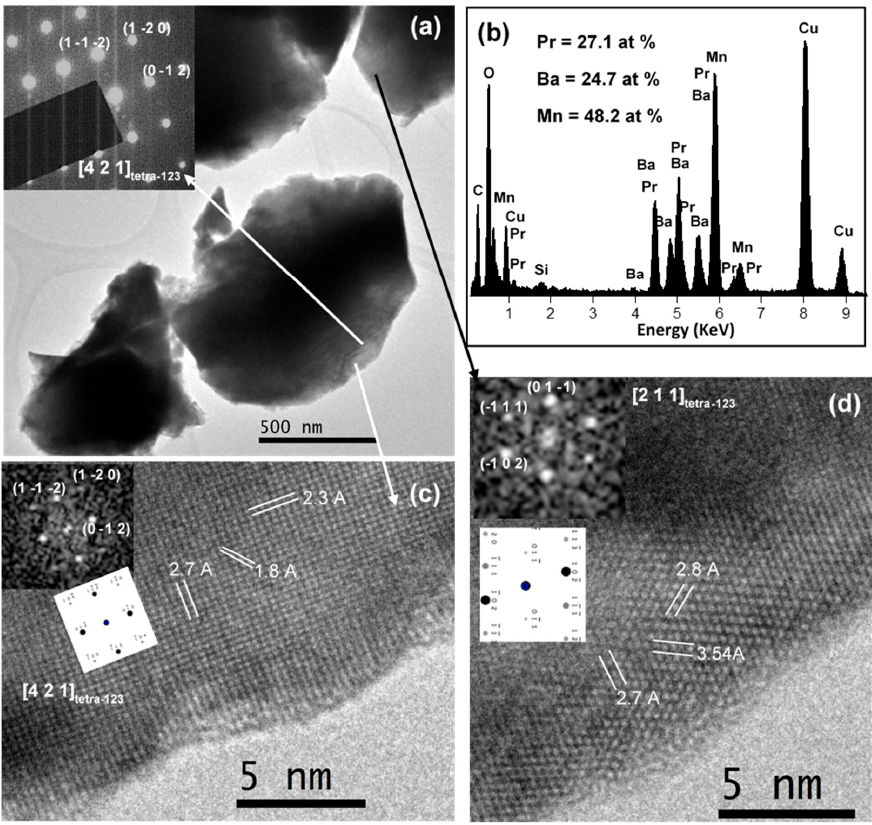
Figure 9. Microcharacterization of PBMO-m + 1150°C/Ar + TG/air sample: ( a ) TEM image and a SAED pattern (inset); ( b ) representative EDX spectrum and the average atomic percentage of the sample; ( c , d ) HRTEM micrographs and the corresponding FFT and simulated ED patterns (insets).